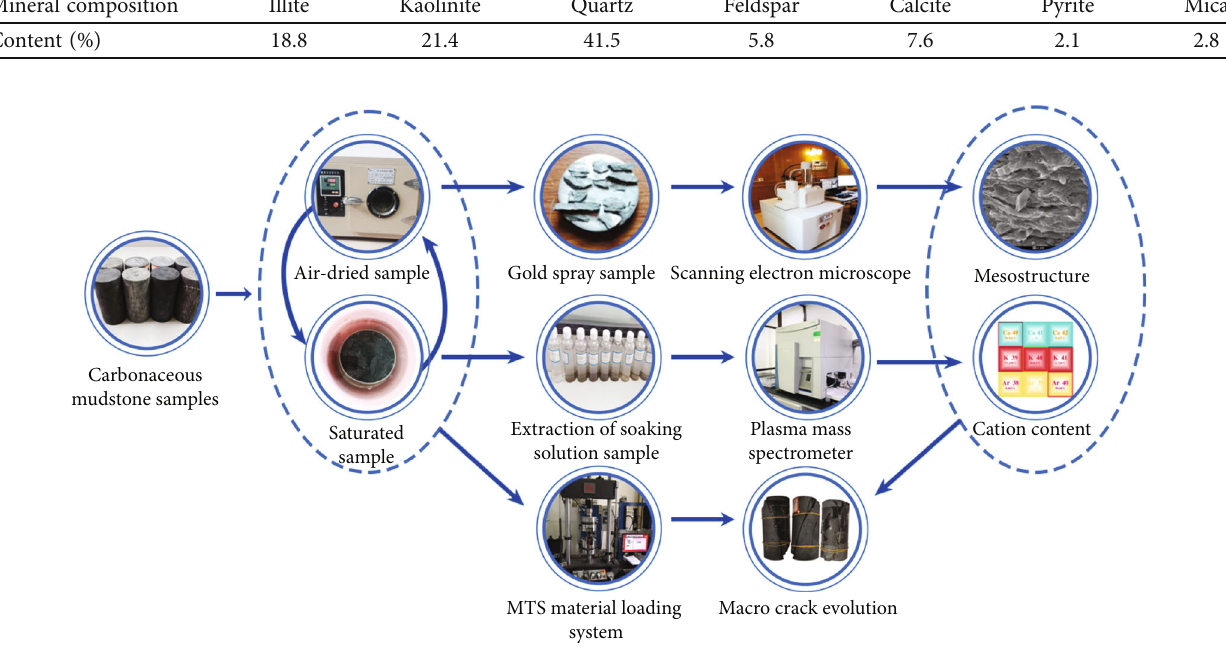
Figure 2: Test process.